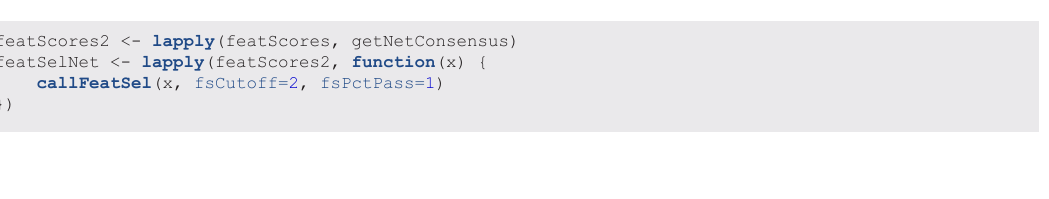
Here is an example of an enrichment map generated by running the above predictor with more real-world parameter values, and all available pathways (Figure 5): Visualize integrated patient similarity network based on top features. We apply a threshold to define the most predictive features, and integrate these into a single patient similarity network. Such a network is useful for down- stream operations such as ascertaining whether or not classes are significantly separated, and for visualization of results.